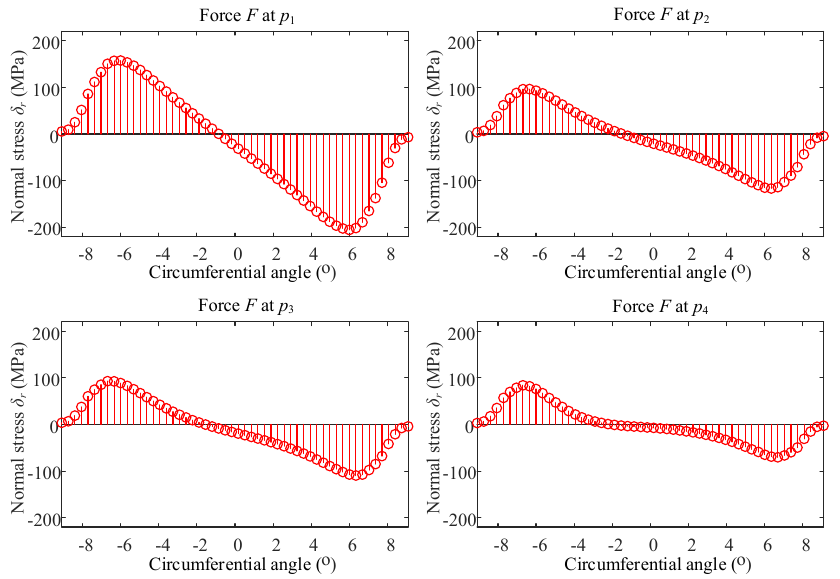
Figure 7. E ff ect of loading locations on tooth root normal Figure 7. Effect of loading locations on tooth root normal stress.